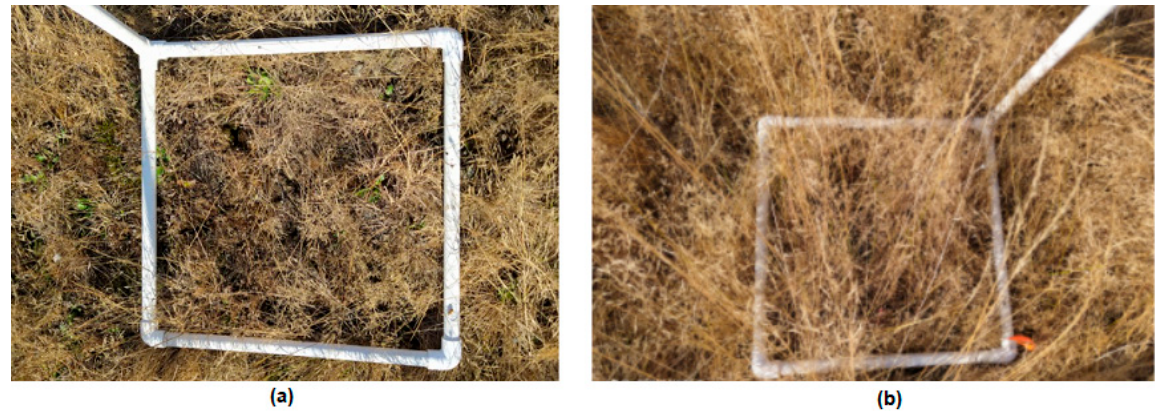
Figure 3. Examples of Plots in Short Grass ( a ) and Tall Grass ( b